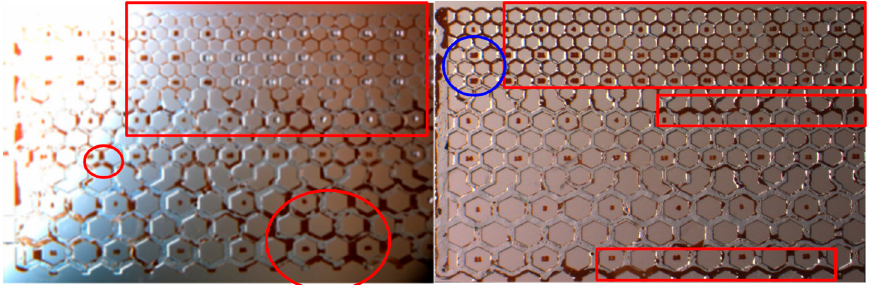
Figure 12. Remaining oil distribution after polymer flooding initiated at S w = 42.79% (left) and 38.83% (right).